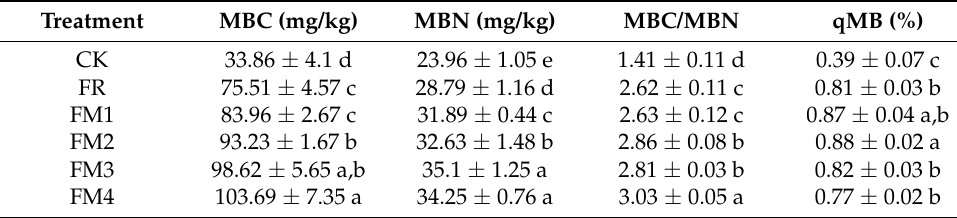
Table 4. Soil MBC and MBN contents under different fertilization treatments.